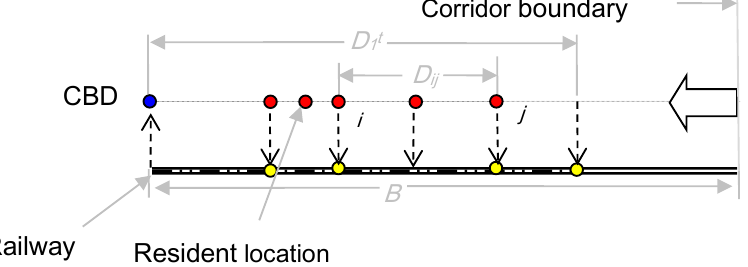
Figure 1. Configuration of residential locations in a railway transportation